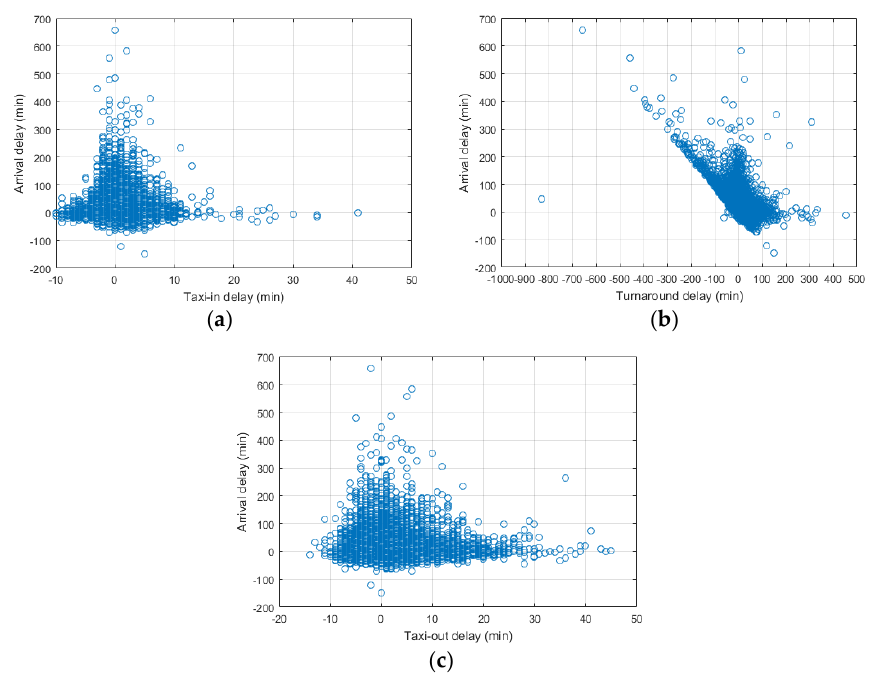
Figure 19. Relationship between arrival delay and ( a ) taxi-in delay; ( b ) turnaround delay; and ( c ) taxi-out delay (min).